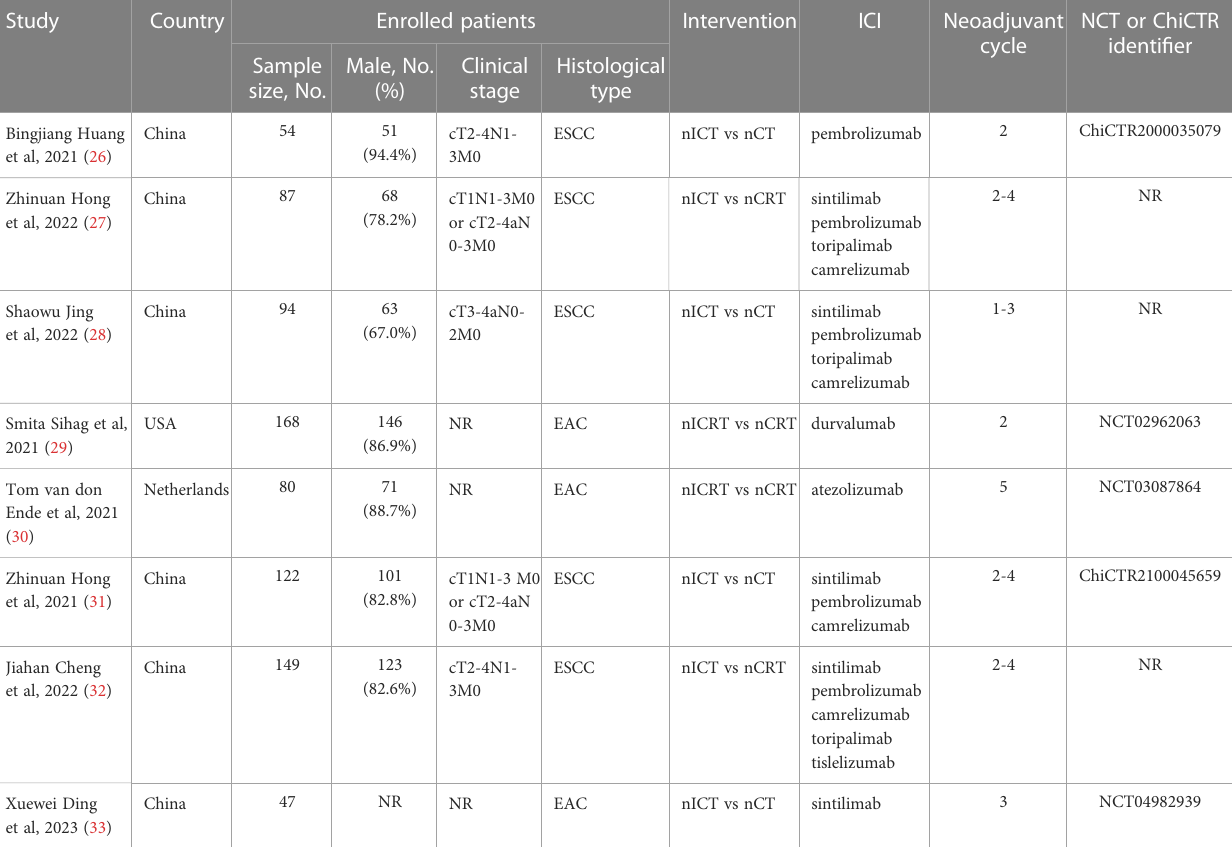
TABLE 1 Characteristics of included studies for the